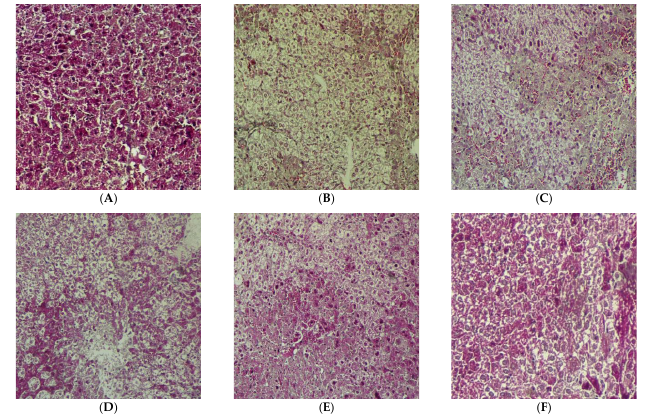
Figure 8. PAS-staining for glycogen storage in the liver sections of all experimental models: ( A ) normal, ( B ) CCl 4 -treated, ( C ) MSCs-treated, ( D ) + MSCs + compound ( 18 )-treated, ( E ) MSCs + compound ( 14 )-treated ( F ) MSCs + compound ( 10 )-treated. MSCs + compound ( 10 ) show increased recovery of glycogen storage (20×; scale bar:100 µm).